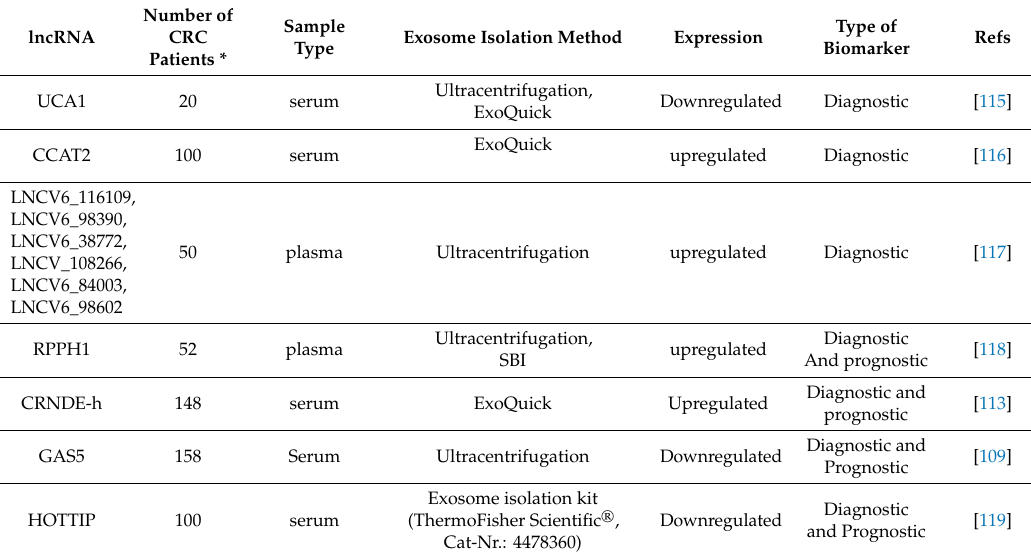
Table 2. Summary of exosomal lncRNA studies in CRC